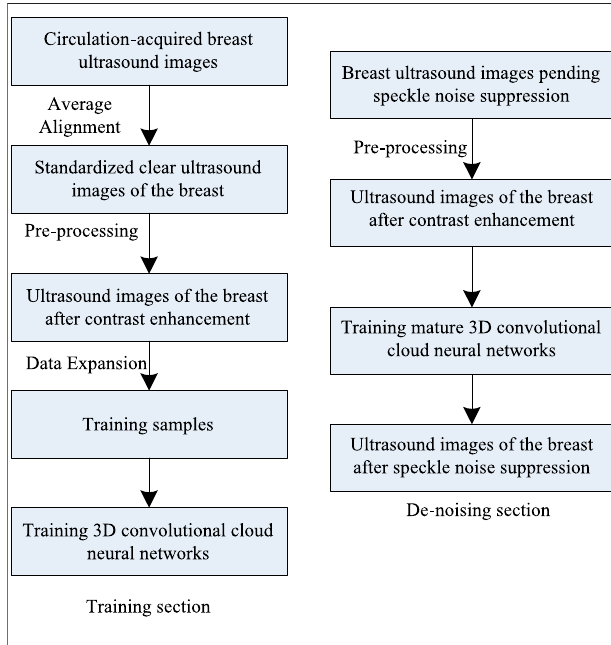
FIGURE 1 | Breast ultrasound image speckle de-noising